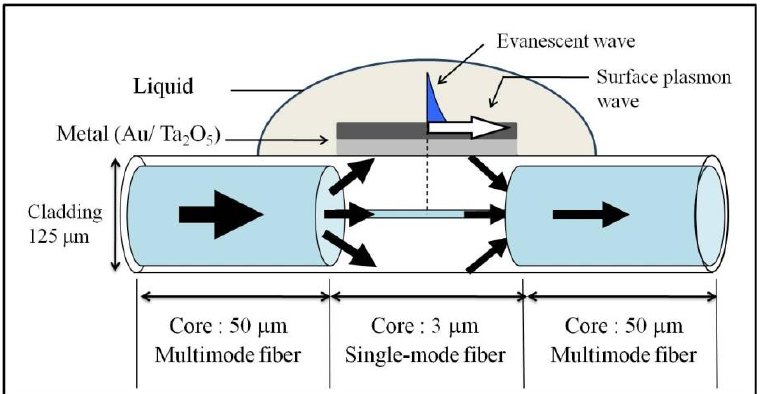
Figure 1. Structure of the hetero-core structured optical fiber SPR